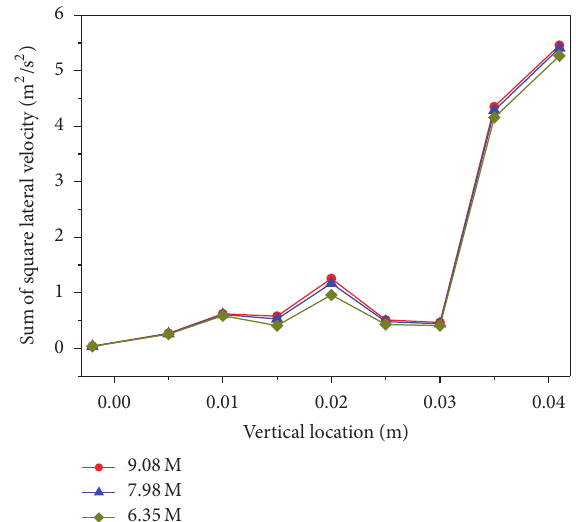
Figure 12: Analysis on square lateral velocity for 5 × 5 grid.